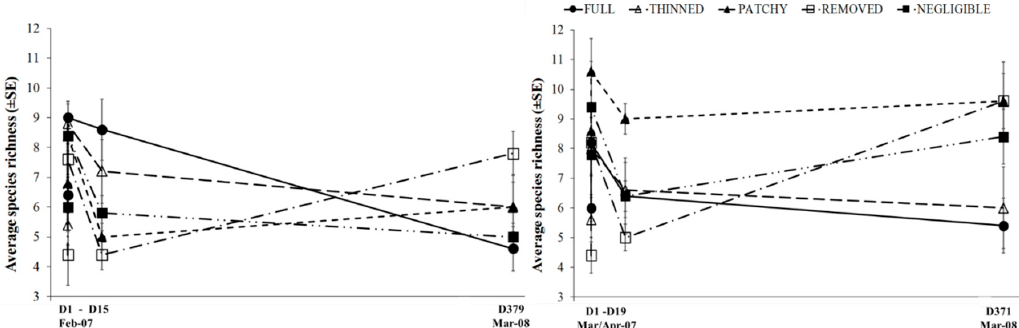
Figure 7. Average species richness ± se between treatments and over time at 13th Beach (left hand side) and Bridgewater Bay (right hand side).